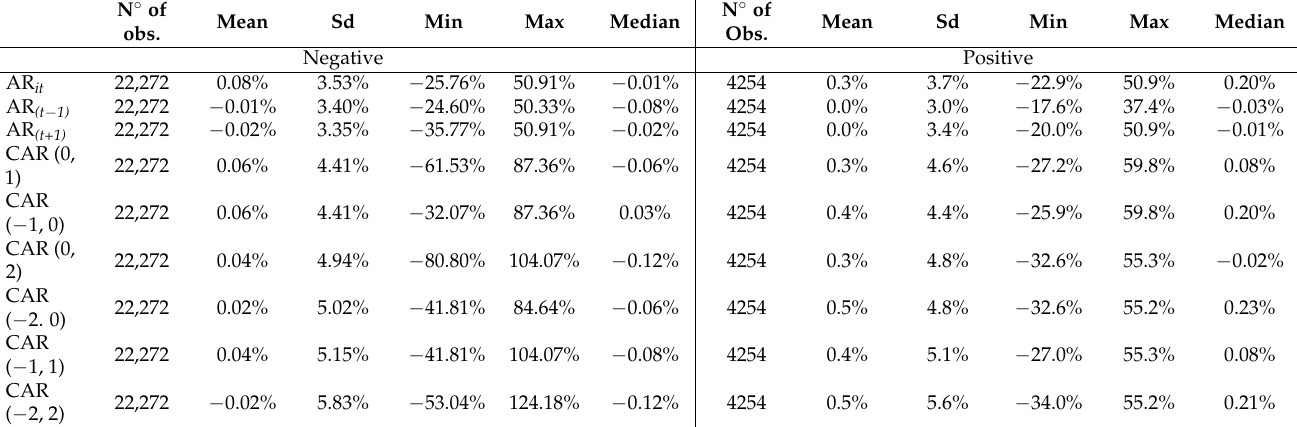
Table 3. Descriptive statistics of short-term ARs and CARs sorted by negative and positive news sentiment. N ◦ of obs.